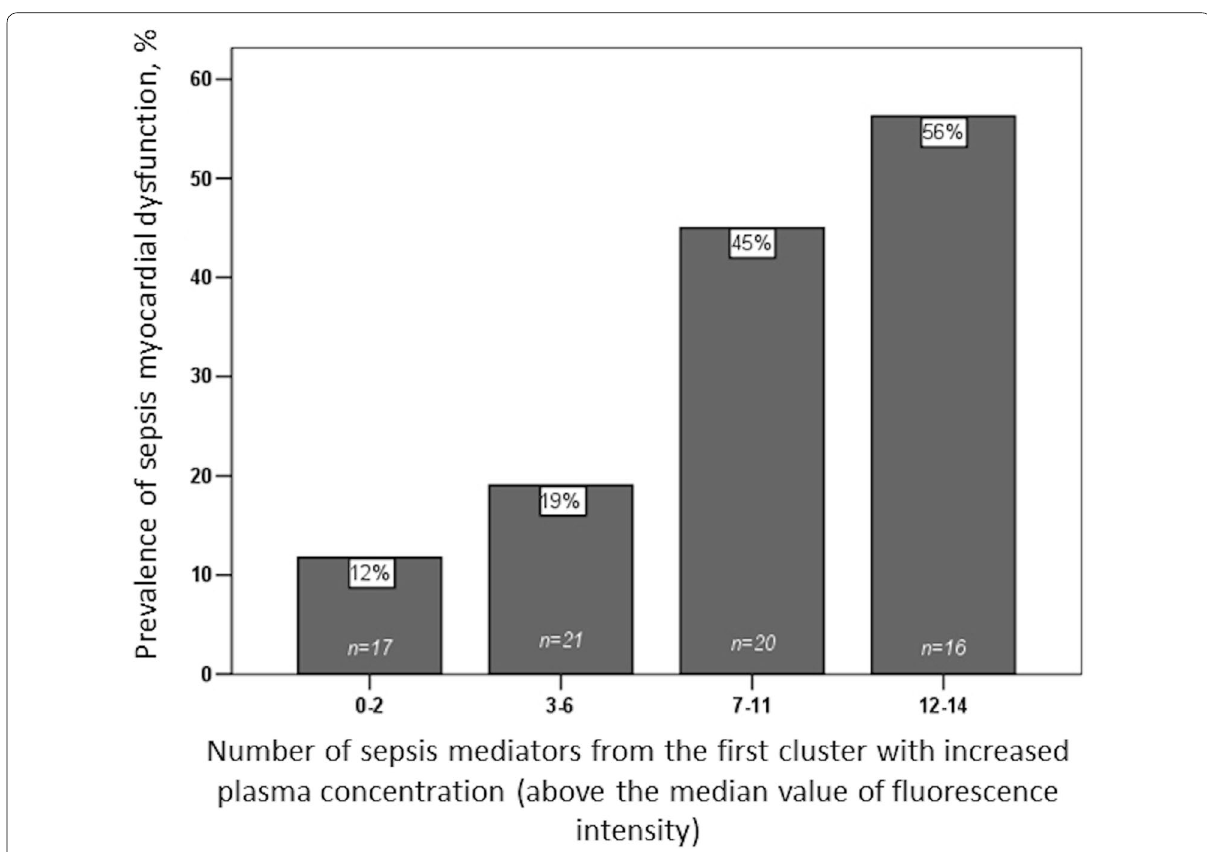
Fig. 3 Prevalence of septic myocardial dysfunction according to the number of increased sepsis mediators (above the median value) from the first